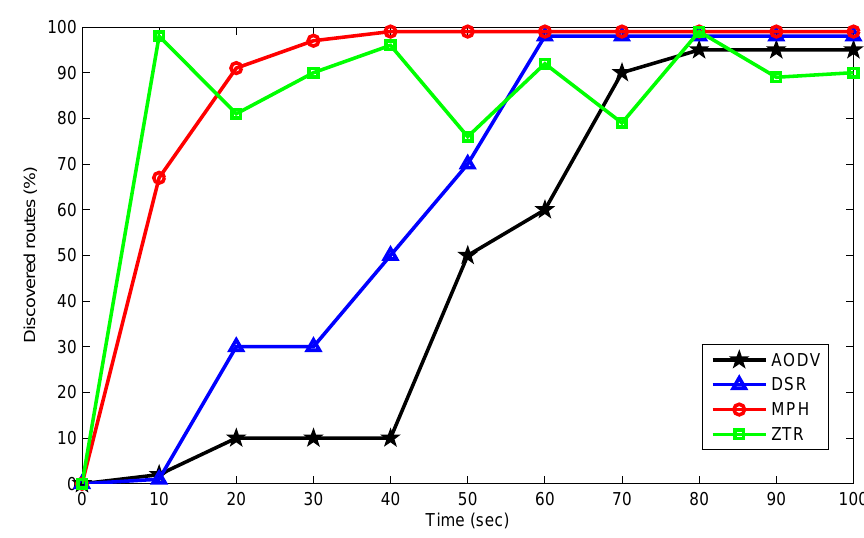
Figure 13. Percentage of discovered routes vs .